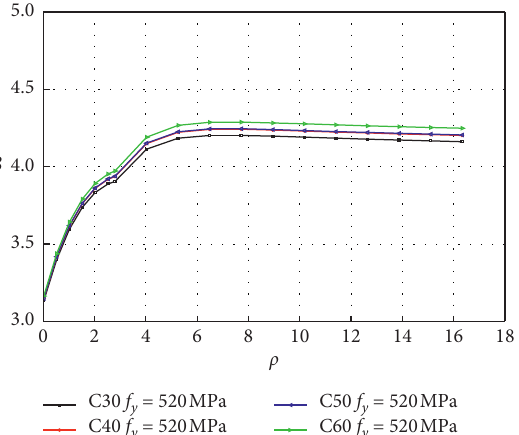
Figure 12: ρ - β Curve of different concrete strength grades with the reinforcement rate of